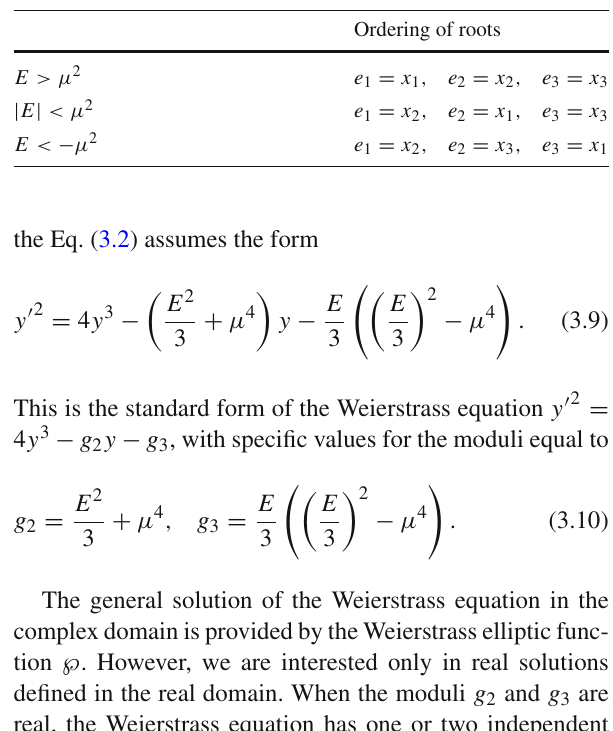
Fig. 1 The roots of the cubic polynomial as function of the integration constant E Table 1 The ordering of the roots